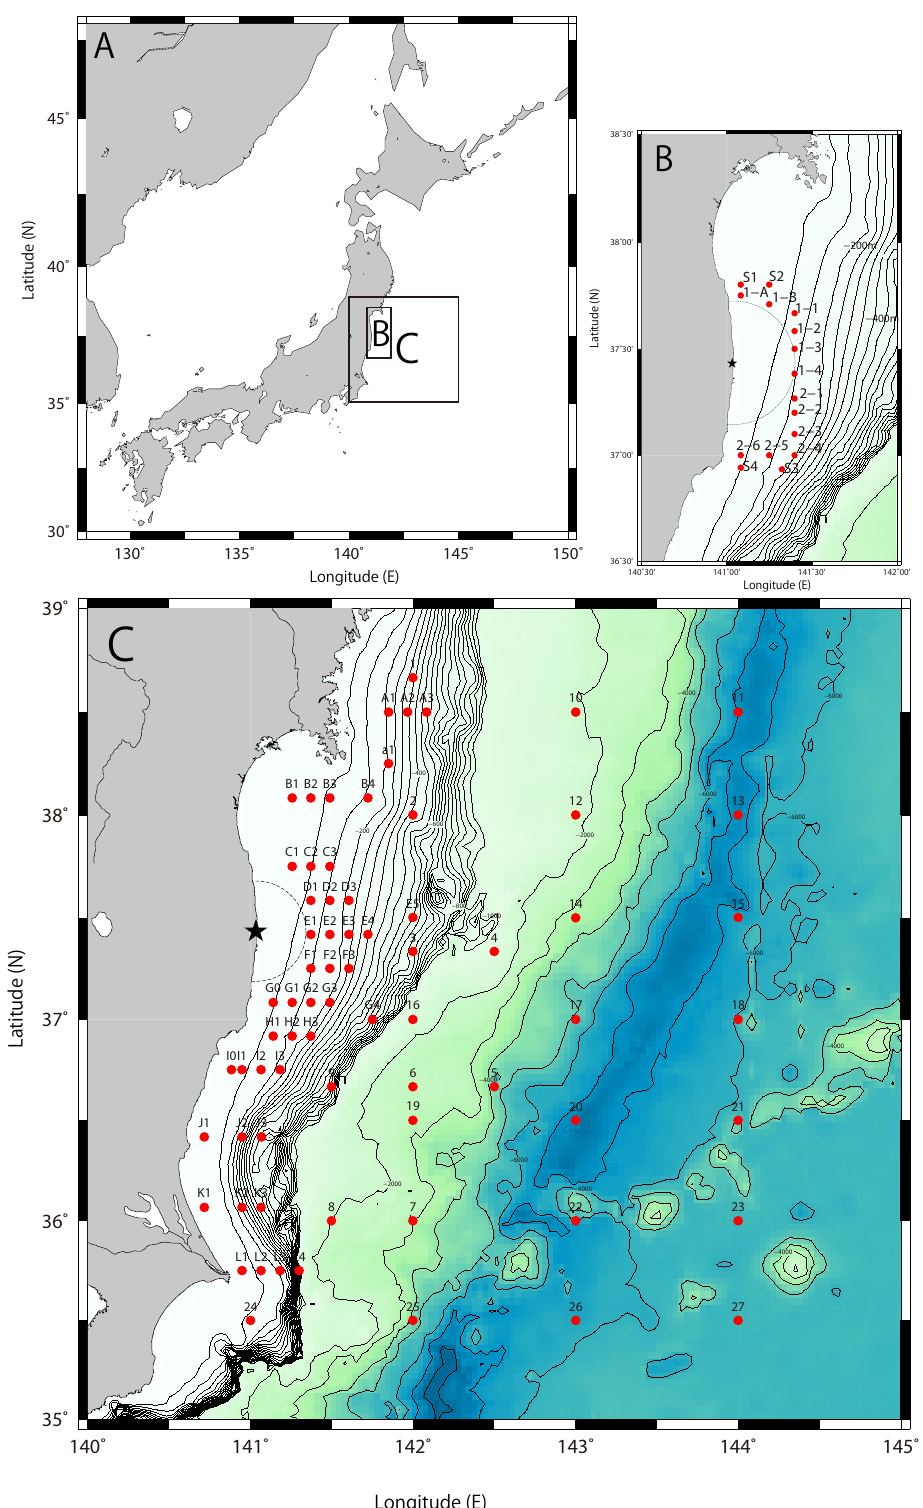
Fig. 1. Locations of sampling areas in coastal areas off Fukushima, Japan (A) and sampling stations during Phase 1 (23 March 2011 to 7 May 2011) (B) and Phase 2 (9 May 2011 to 21 February 2012) (C)